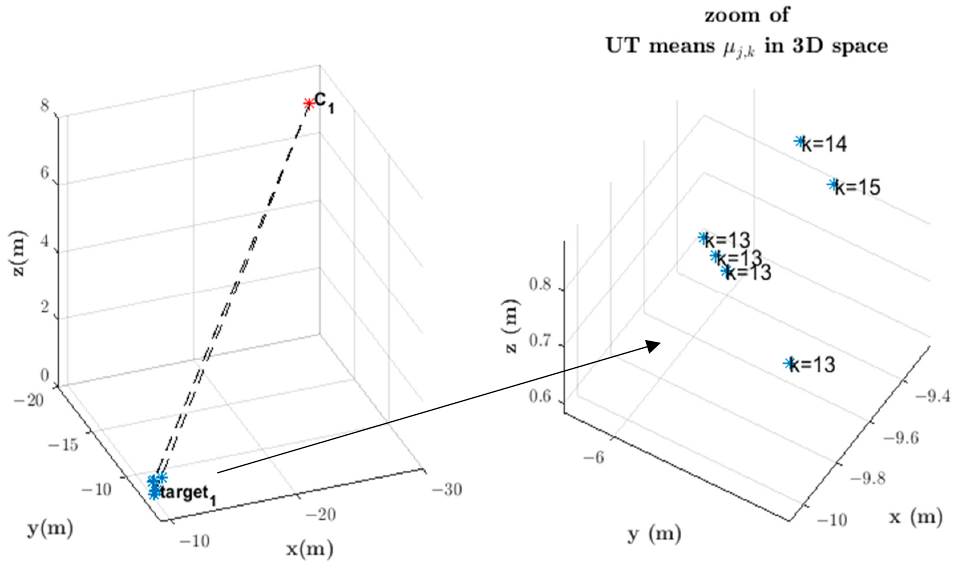
Figure 14. An instance of distinct UT means µ jk , j = 1, . . . , n in 3D space at instant k for the sets of 3D points shown in Figure 13.